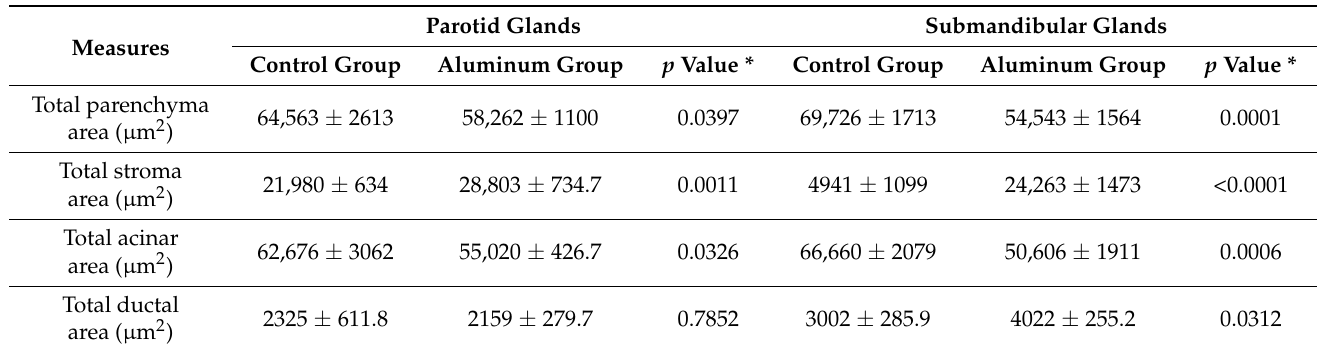
Table 1. Morphometric measurements of the rats’ salivary glands after long-term exposure to aluminum, n = 8/group (mean ± SEM).